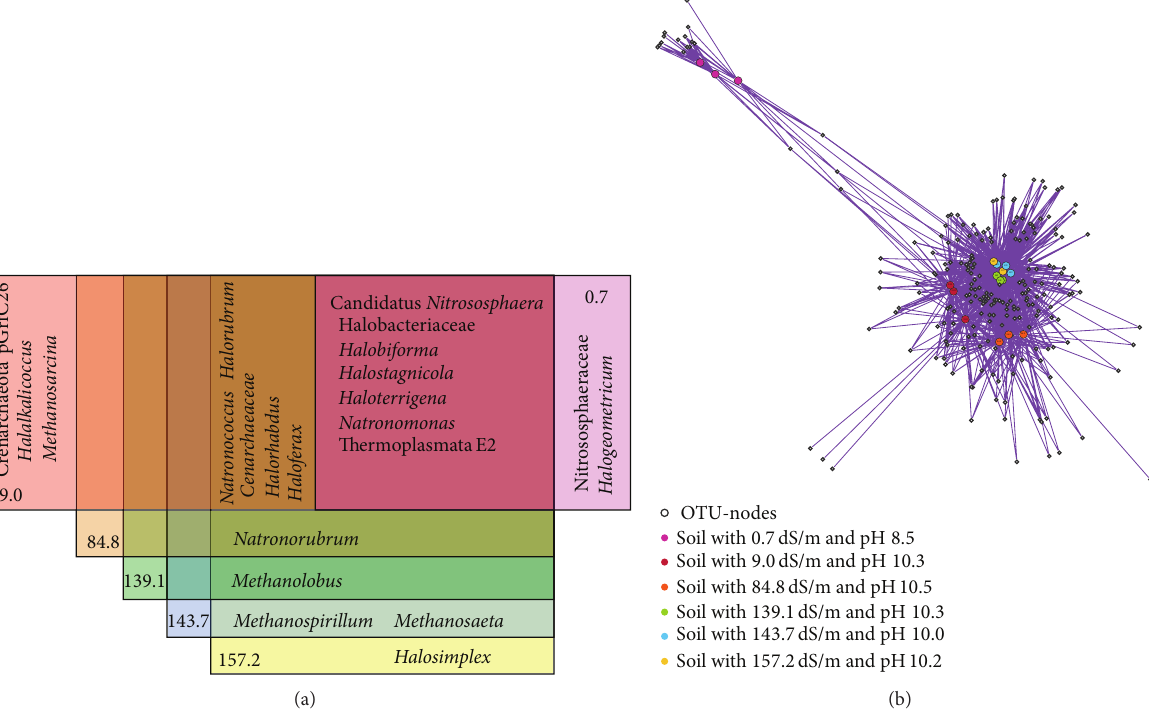
Figure 3: Shared taxonomic groups and operational taxonomic units (OTUs) at 97% cut-off in alkaline-saline soils of the former lake Texcoco with different electrolytic conductivity and pH. (a) Venn diagrams of cooccurrence of taxonomic groups. (b) Network plot of occurrence of OTUs. OTU-nodes (white circles) are connected via edges (lines) to sample-nodes (large circles) in which their sequences are found. Edge weights (lines’ length) are defined as the number of sequences in an OTU.